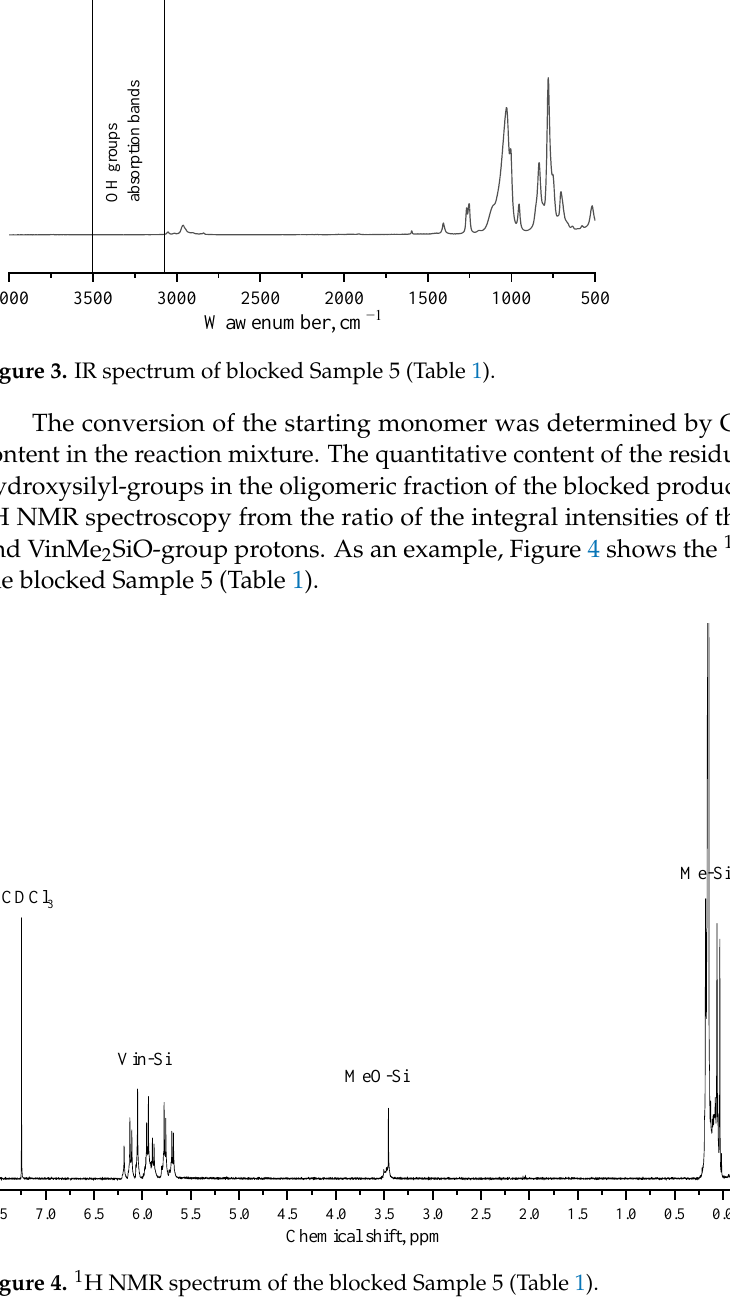
Figure 4. 1 H NMR spectrum of the blocked Sample 5 (Table 1).